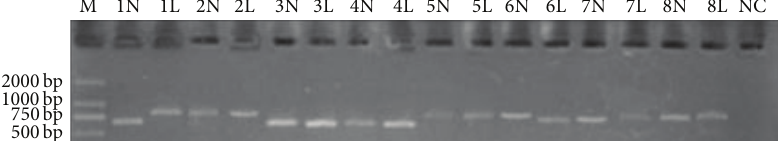
Figure 1: Electropherogram of the lesional and nonlesional skin DNA samples from patients 1–8 after ITS1/ITS4 amplification. The lanes of the lesional scales are coded as the patient number + L (lesion), and the lanes of the nonlesional skin samples are coded as the patient number + N (normal). M signifies the marker, and NC signifies the negative control. Positive bands appeared at the 600–800 bp position in each sample lane. No band appeared in the NC.